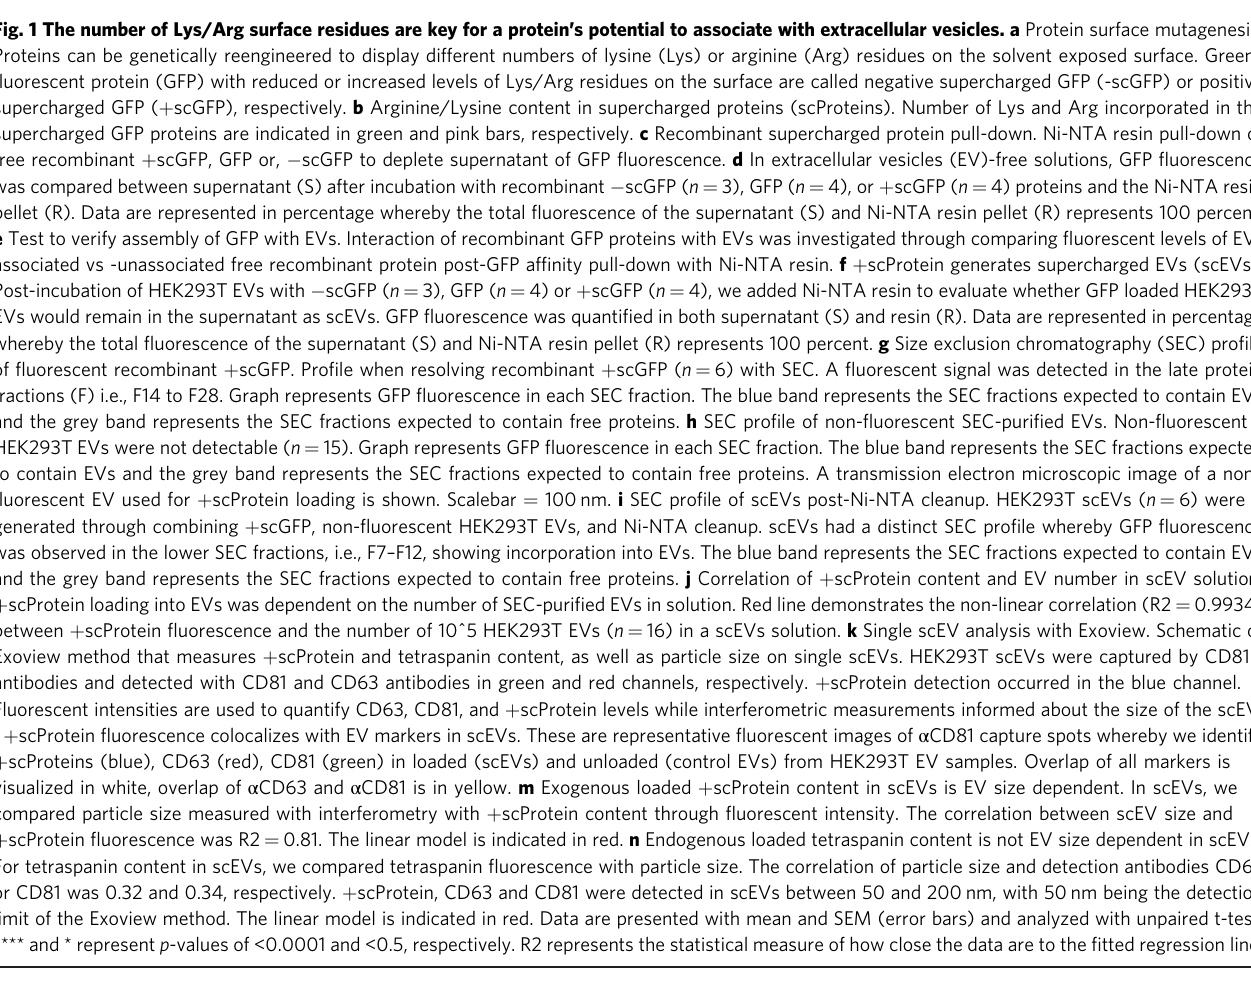
Fig. 1 The number of Lys/Arg surface residues are key for a protein ’ s potential to associate with extracellular vesicles. a Protein surface mutagenesis. Proteins can be genetically reengineered to display different numbers of lysine (Lys) or arginine (Arg) residues on the solvent exposed surface. Green fl uorescent protein (GFP) with reduced or increased levels of Lys/Arg residues on the surface are called negative supercharged GFP (-scGFP) or positive supercharged GFP ( + scGFP), respectively. b Arginine/Lysine content in supercharged proteins (scProteins). Number of Lys and Arg incorporated in